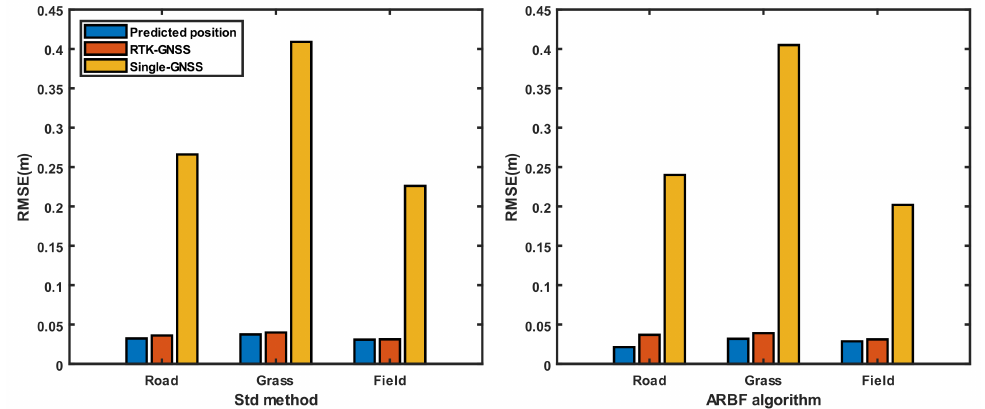
Figure 8. RMSE results of dynamic experiments in the three different environments.